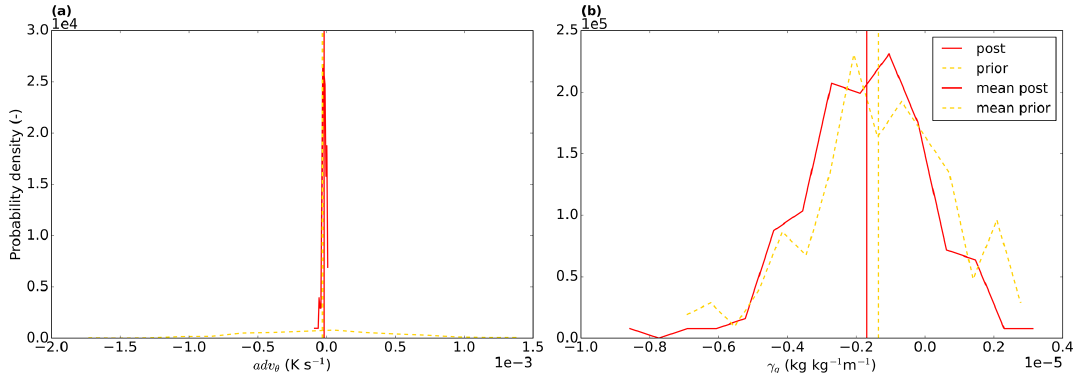
Figure 8. Probability density functions for the adv θ (a) and γ q (b) parameters. The red full line is for the posterior and the yellow dashed line for the prior distribution. The vertical lines represent the mean of the distributions. For each probability density function, 15 bins were used. Note that the prior distribution is determined from the sample of priors, which has a component of